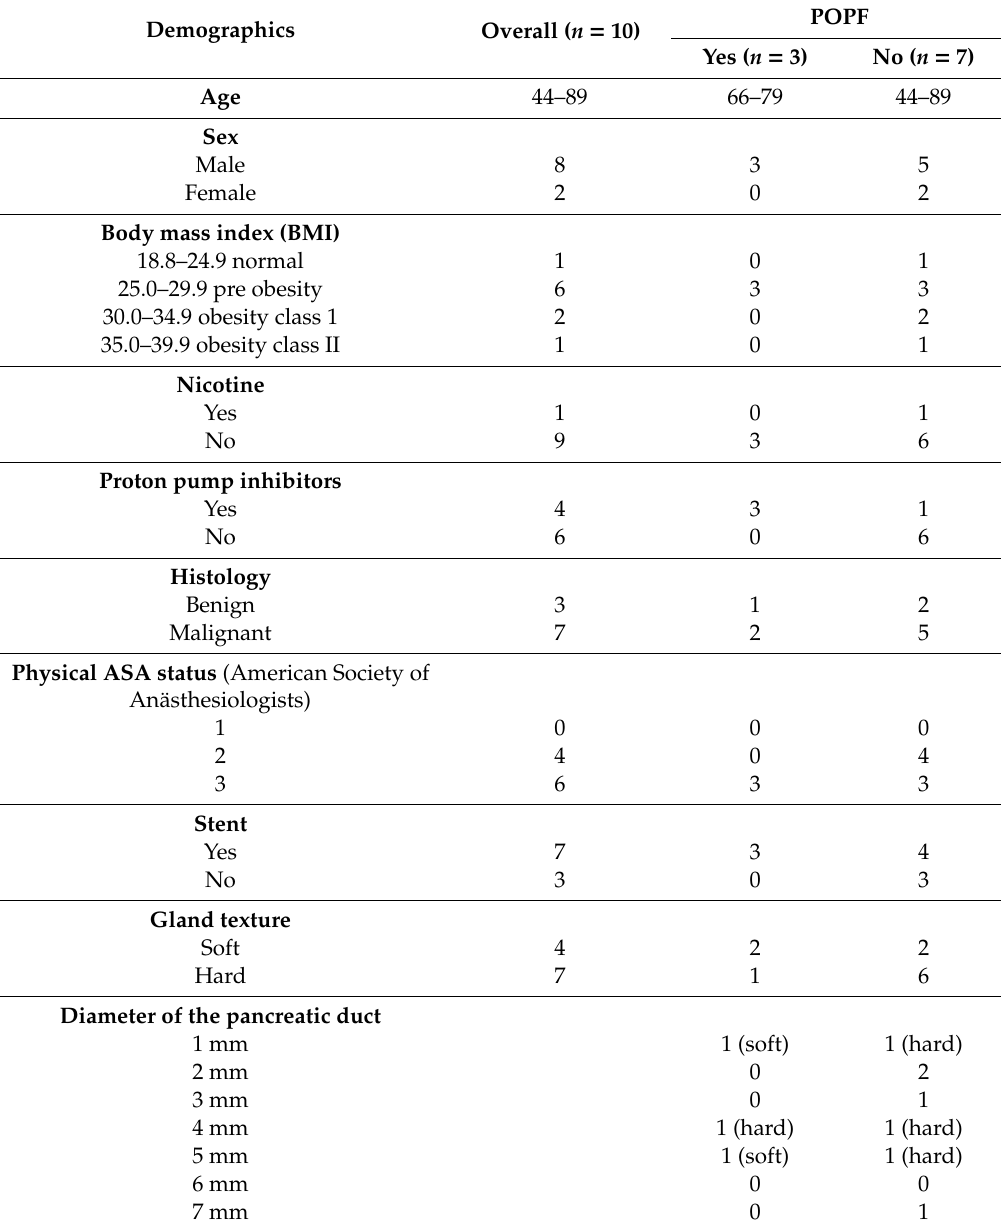
Table 1. Clinical characteristics of study